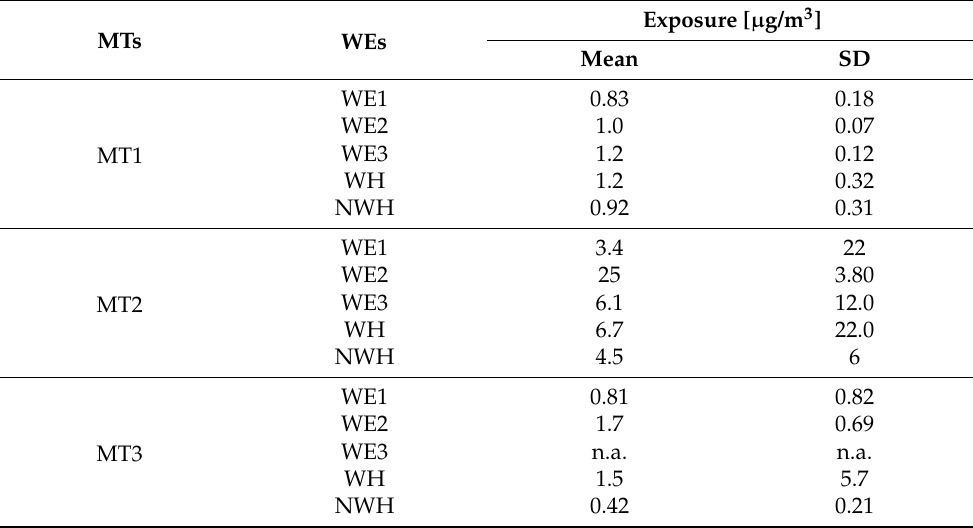
Table 2. Exposure to carbon nanotubes expressed as mass concentrations [ µ g/m 3 ] for the three selected work events (WEs), characterized by means of different measurement techniques (MTs). The data are presented as mean and standard deviation (GSD). Note: n.a. = not